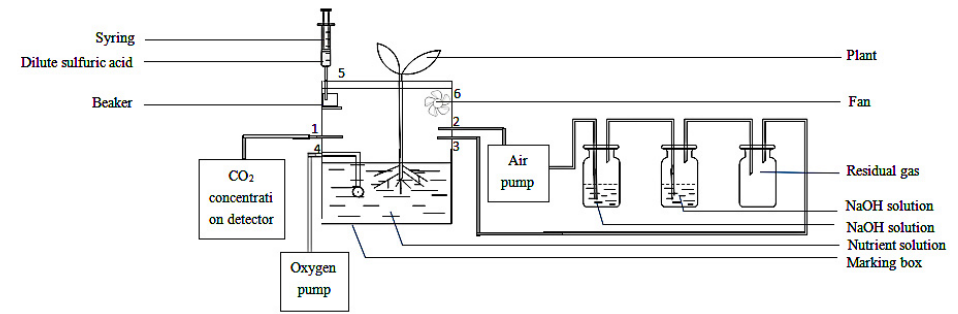
Figure 10 . Isotope tracer processing system . Figure 10. Isotope tracer processing